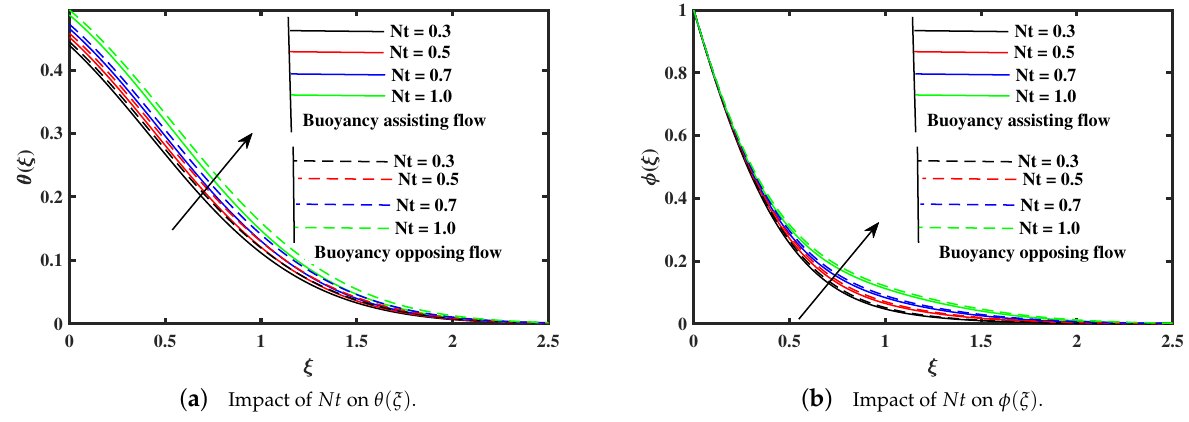
Figure 9. Fluctuation of θ ( ξ ) and φ ( ξ ) against thermophoresis ( Nt ).